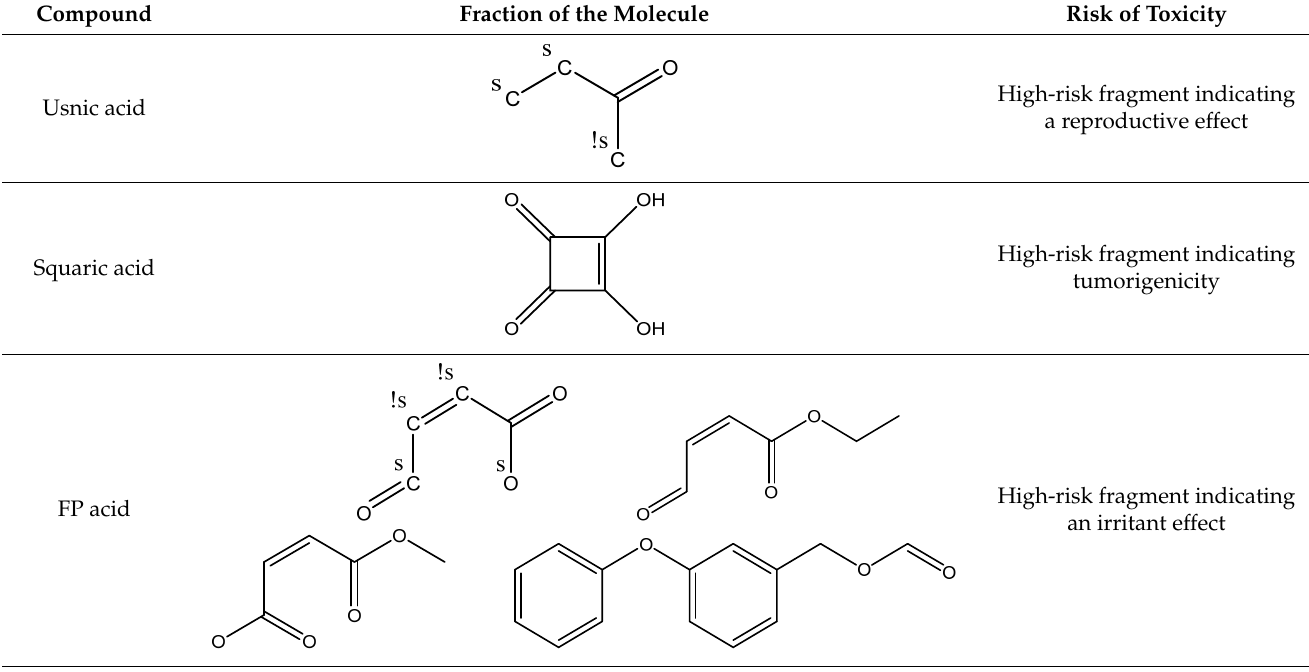
Table 5. Structural fragments responsible for the toxicity of the compounds present in the species of Table 5 . Structural fragments responsible for the toxicity of the compounds present in the species Table 5 . Structural fragments responsible for the toxicity of the compounds present in the species the genus Cladonia . of the genus Cladonia . Table 5 . Structural fragments responsible for the toxicity of the compounds present in the species of the genus Cladonia . of the genus Cladonia .